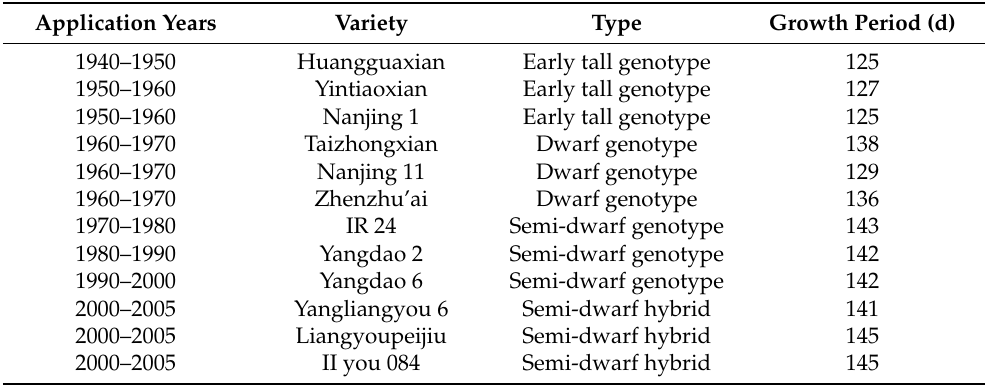
Table 2. The tested mid-season indica rice genotypes in this